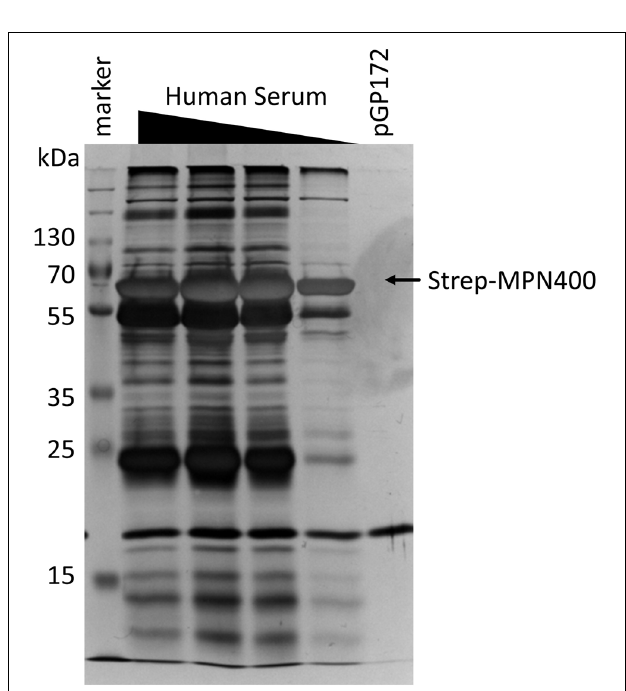
FIGURE 5 | Detection of proteins bound by immobilized MPN400. The binding was performed with recombinant MPN400 (from E. coli BL21:pGP3215) immobilized to StrepTactin matrix, which was incubated with different concentrations of human serum (HuSe). Columns were washed extensively, and bound proteins eluted four times with D -desthiobiotin. We used the fractions from elution 3 to analyze the protein content by 12% SDS-PAGE stained with silver. Lane 1, pre-stained protein ladder plus (Thermo Fisher); lanes 2–5, rMPN400 incubated with 5, 3, 2, and 1 µ g protein from HuSe, respectively; lane 6, empty vector crude extract from E. coli incubated with 5 µ g